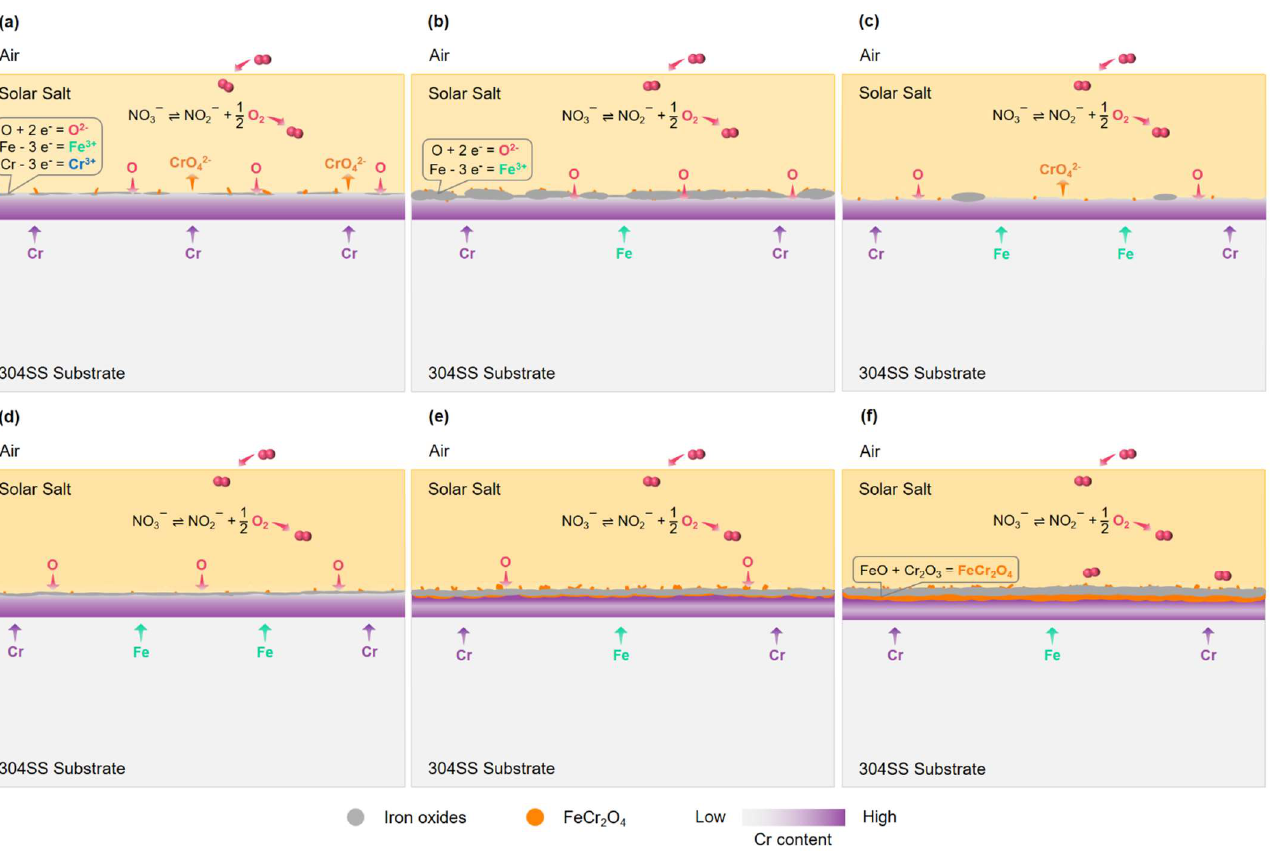
Figure 12. Schematic of the corrosion process of 304SS alloy exposed to Solar Salt at 565 °C for 15 days. ( a – c ) Earlier corrosion period, ( d – f ) Later corrosion period.